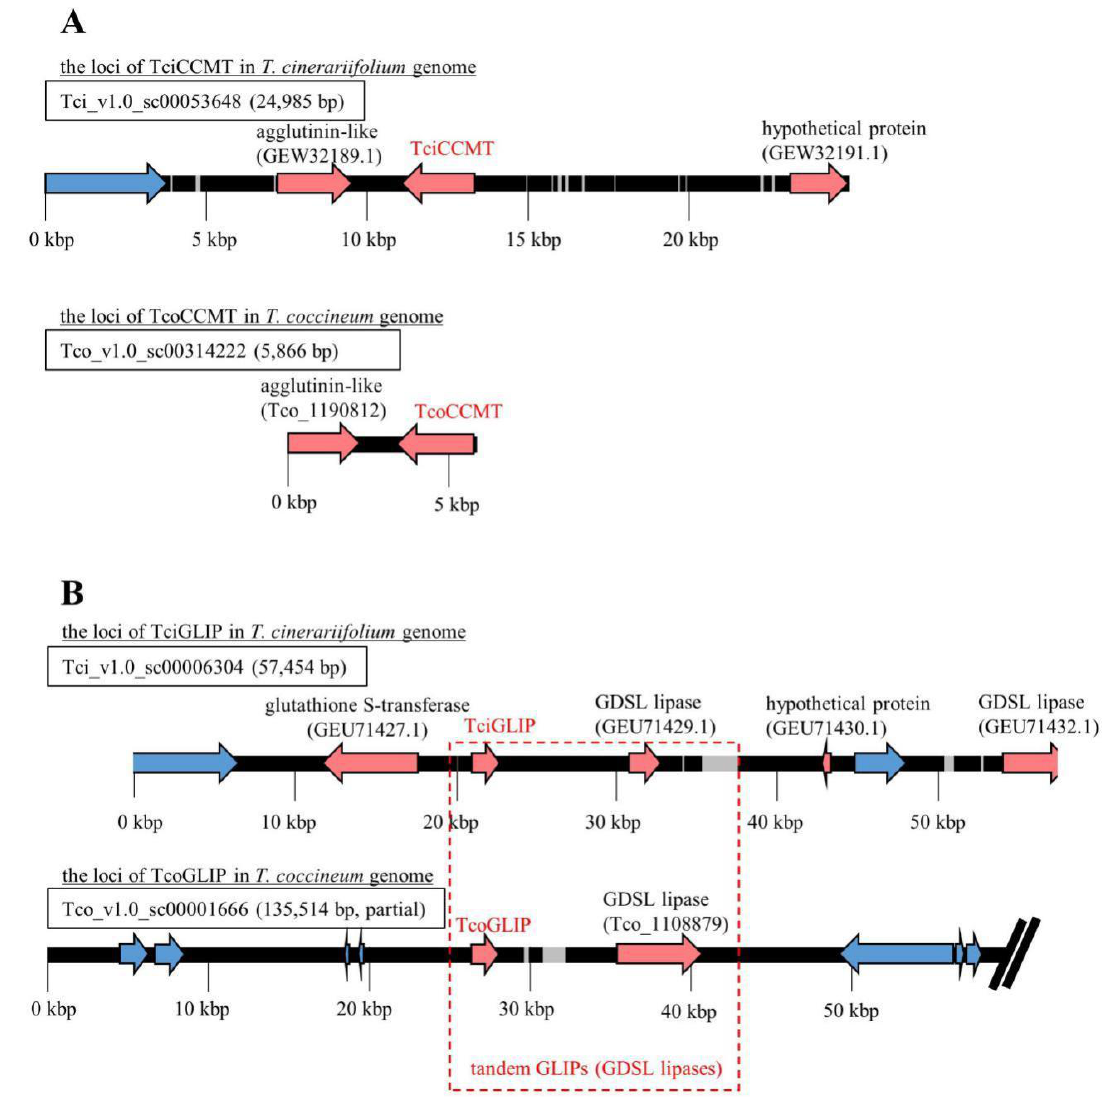
Figure 4. Scaffolds including genes encoding the pyrethrin-related enzymes Tci(o)CCMT ( A ) and Tci(o)GLIP ( B ). Gray region: gap; red arrows: protein-coding gene; blue arrow: transposable element (TE) gene.